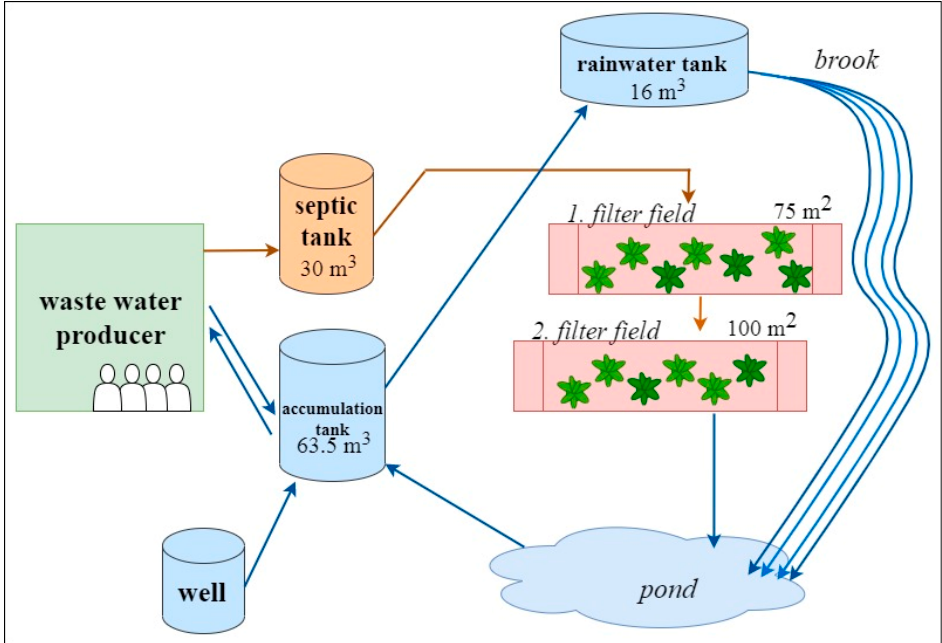
Figure 4. The circulation of the water from surface runoff and waste water in the facility (according to the project documentation of ECOPLANET SLOVAKIA, s.r.o.; [19]).